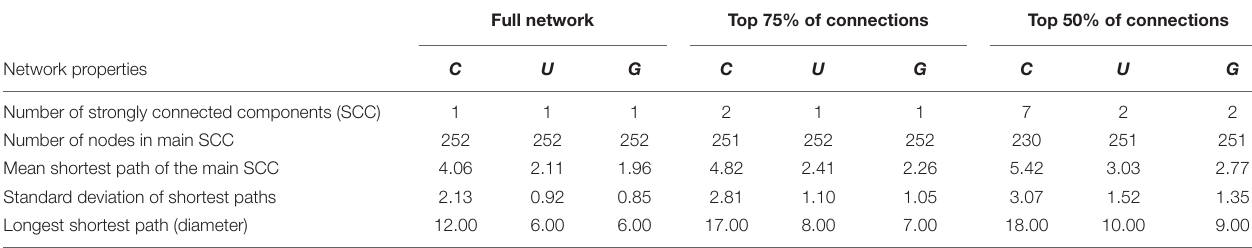
TABLE 1 | Topology of the three organism-specific networks.